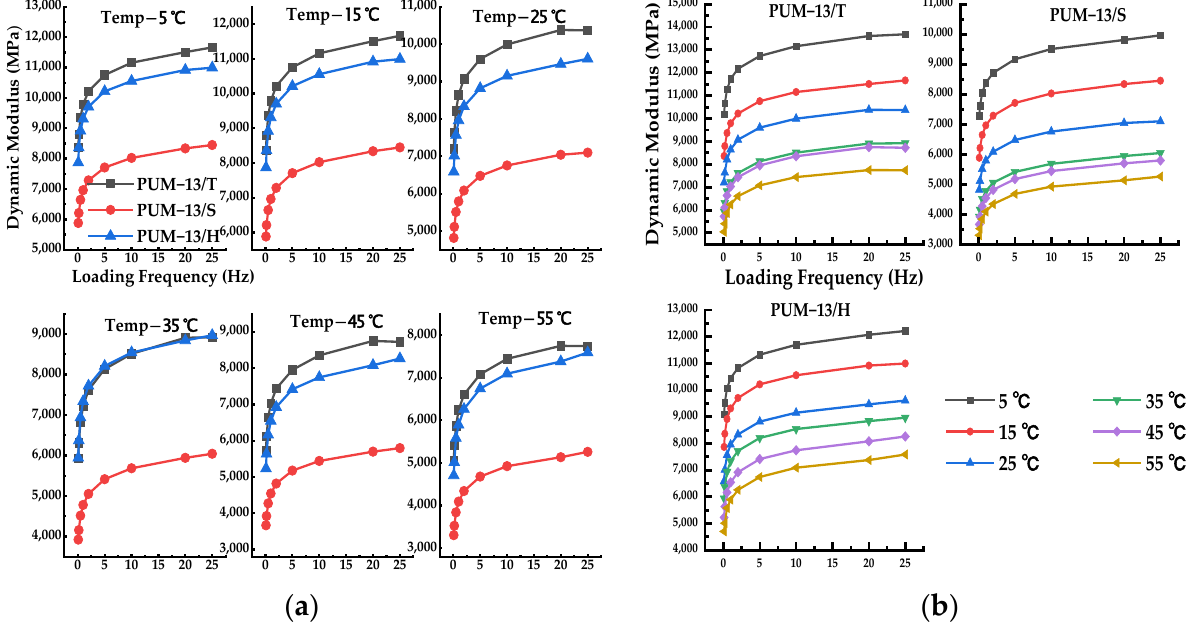
Figure 8. The dynamic modulus of the PU mixtures with the same gradation and different PU types. ( a ) dynamic modulus under different test temperatures, ( b ) dynamic modulus with different PU types.